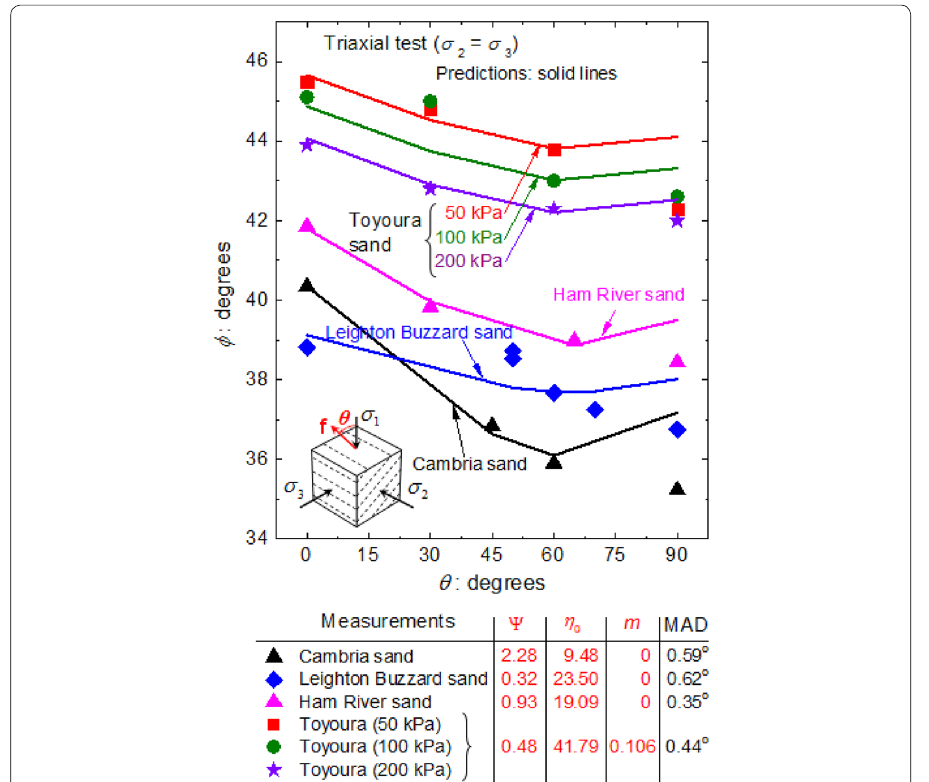
Fig. 14 Comparison between triaxial test results of four sands and predictions by this